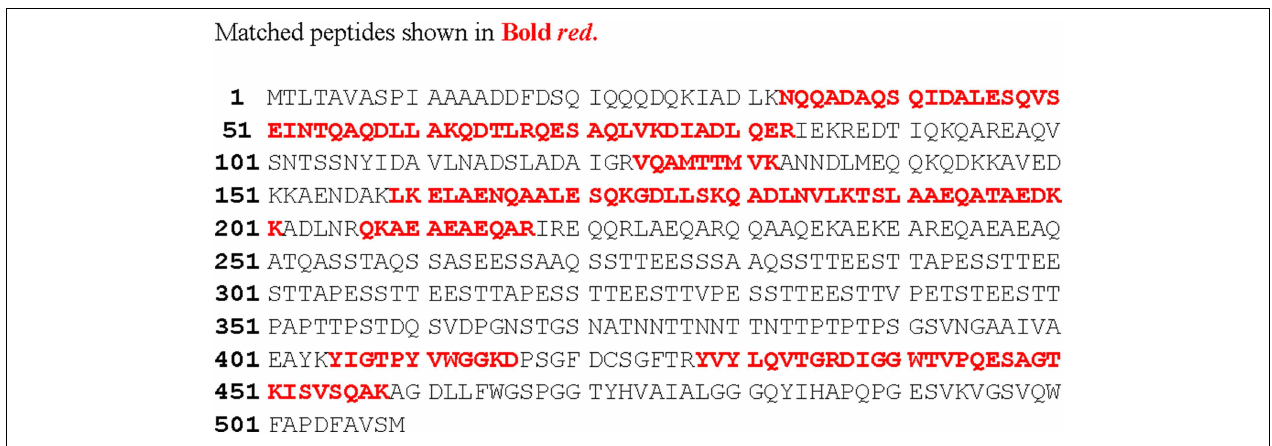
FIGURE 5 | Aligned amino acid sequence (in red, bold font) of the novel protein with sequences from the amino acid database of Mascot and LudwigNR.